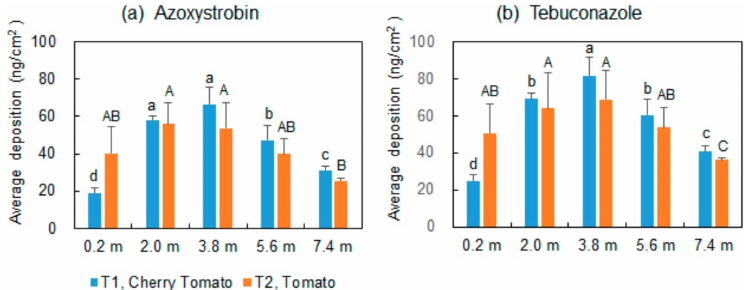
Figure 4. Average depositions of ( a ) azoxystrobin and ( b ) tebuconazole loss to ground at different distance away from the atomizer (bars with different letters are significantly, Duncan’s test, p < 0.05).